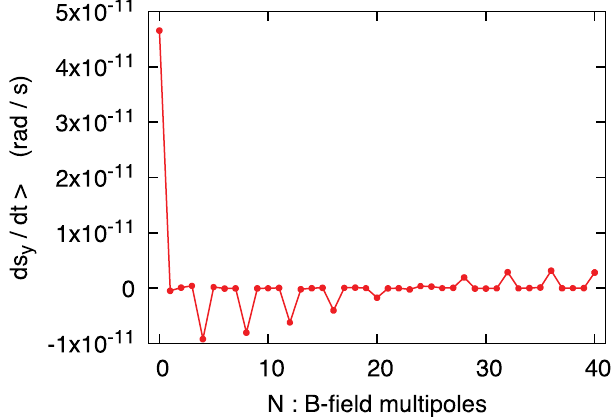
FIG. 5. The vertical spin precession of the counterrotating beams when only magnetic focusing is used, for different radial B-field multipoles ( N -values). The amplitude of the radial B-field is always kept at 1 pT, while the quadrupole strength is kept at (cid:3) 0 . 1 T = m. A genuine EDM signal for 10 − 29 e · cm is larger than 1 nrad/s, and therefore much larger than the background signal.